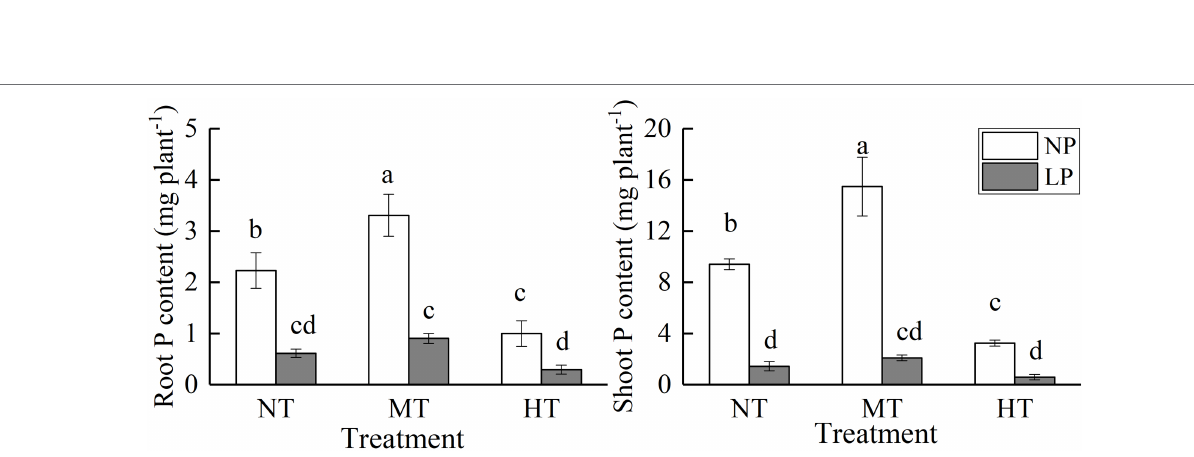
FIGURE 2 | Effect of root zone temperature and phosphorus content on root MDA content and root vitality. NT: 24 ° C, MT: 30 ° C, and HT: 36 ° C (root zone temperature); LP: 1.25 μ m and NP: 250 μ m (phosphorus content). Notations above bars of a, b, c, d, and e indicate homogeneous groups ( α = 0.05).